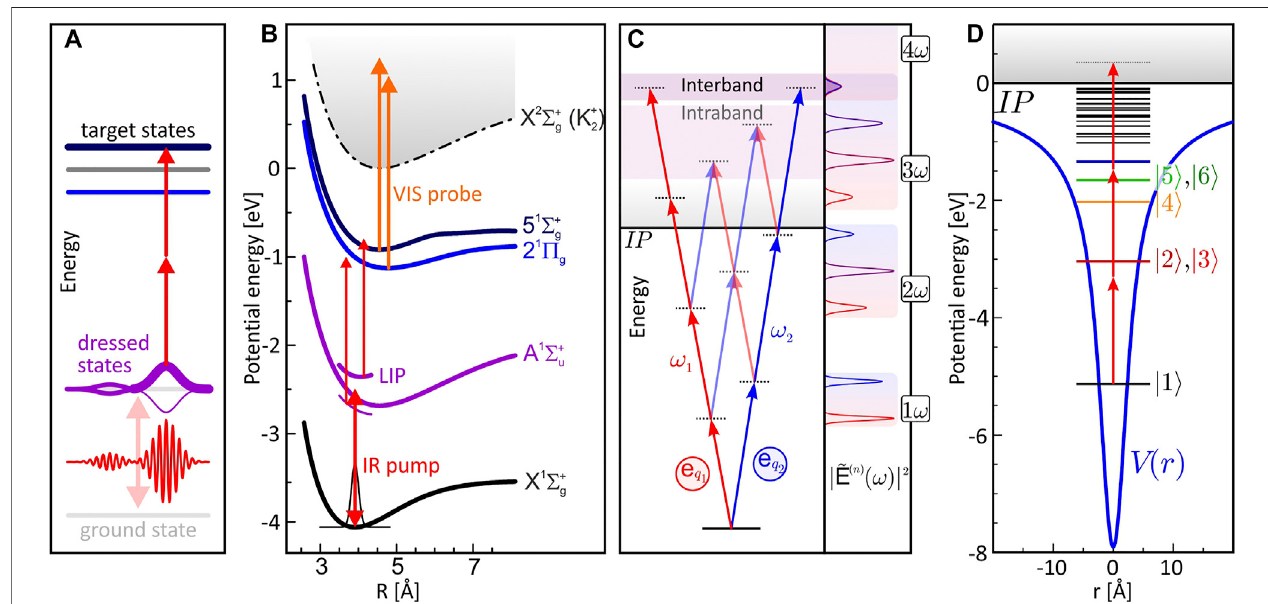
FIGURE1 | Generic ionization schemes: (A) and (B) Non-perturbative neutral dynamicsperturbatively coupled tothe continuum [119]. (A) Genericschemefor the selective population of dressed states [119]. (B) Light-induced potentials of potassium dimers for ultrafast switching via the selective population of dressed states. (C) Scheme for perturbative control of intraband [73] and interband [105] MPI with polarization-shaped pulses along with multiphoton spectra. (D) Model potential for ab initio simulations of MPI with cycloidal laser pulses